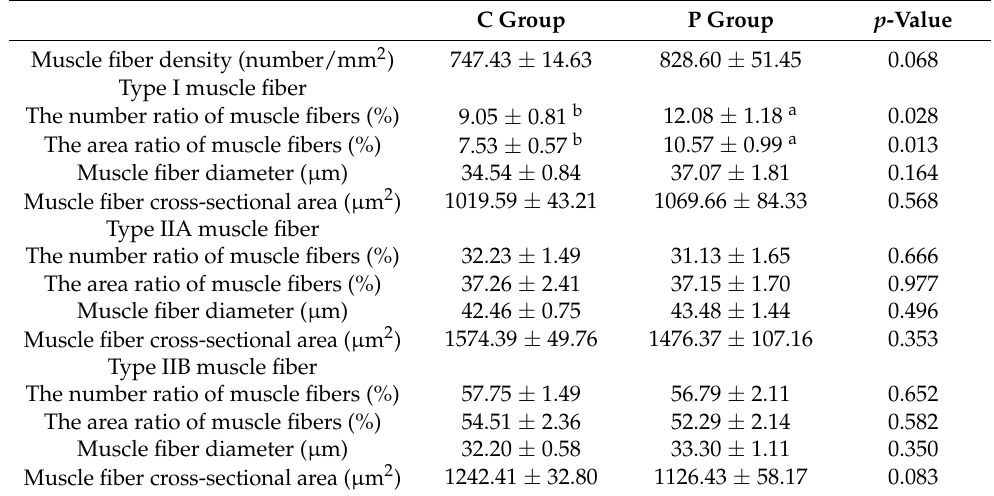
Figure 2. ATPase staining results for the muscle longissimus thoracis of Sunit lambs. A magnification of 200 × was used (bar = 200 µ m). I: fiber type I, black; IIA: fiber type IIA, white; IIB: fiber type IIB, brown. Table 2. Effects of probiotics on the muscle fiber properties of Sunit lambs.